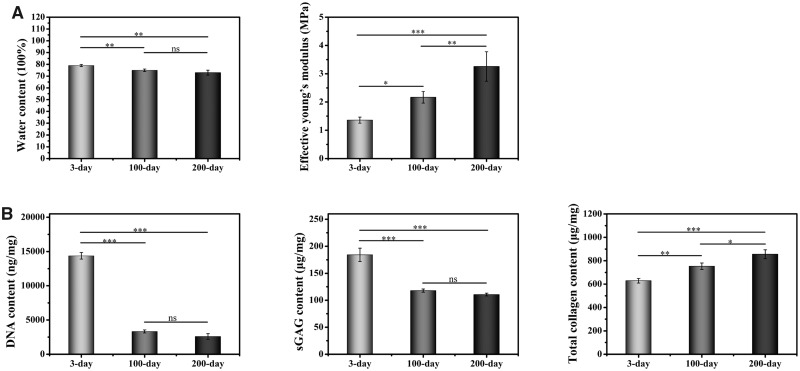
Characterization of native cartilage tissue from newborn, juvenile or adult rabbits. (A) Water content (left) and mechanical strength (middle). (B) DNA, sGAG and total collagen content (n = 3). ns indicates P > 0.05, * indicates P < 0.05, ** indicates P < 0.01 and *** indicates P < 0.001.